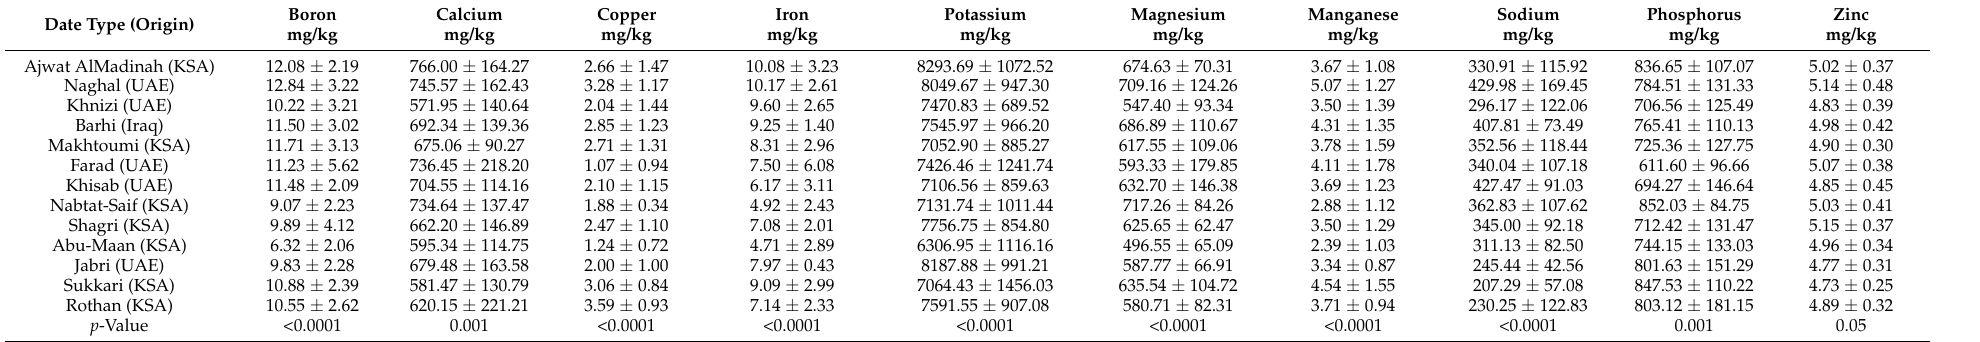
Table 1. The mean mineral composition of date palm fruits grown under different salinity conditions.